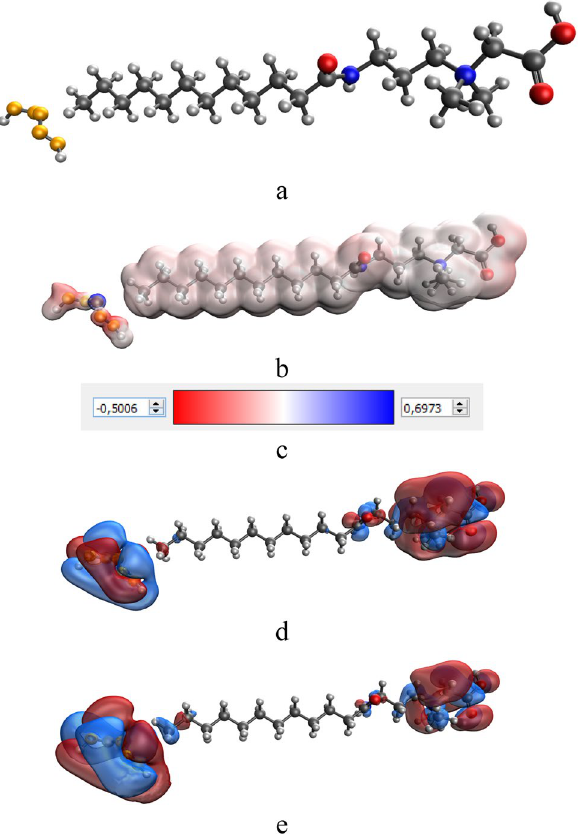
Figure 4. Quantum chemical modeling of the Se-CAPB molecular complex: ( a ) molecular complex model, ( b ) electron density distribution, ( c ) electron density distribution gradient, ( d ) the highest occupied molecular orbital (HOMO), ( e ) the lowest occupied molecular orbital (LUMO).